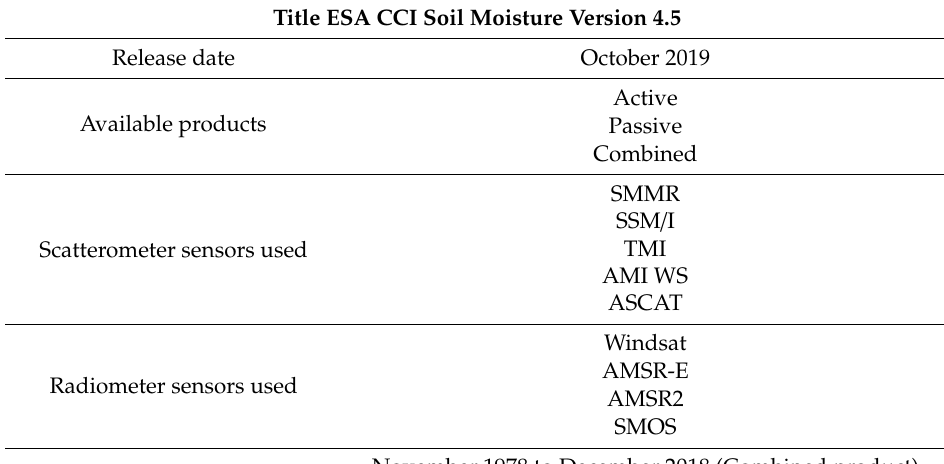
Table 1. Main characteristics of ESA CCI soil moisture version 4.5